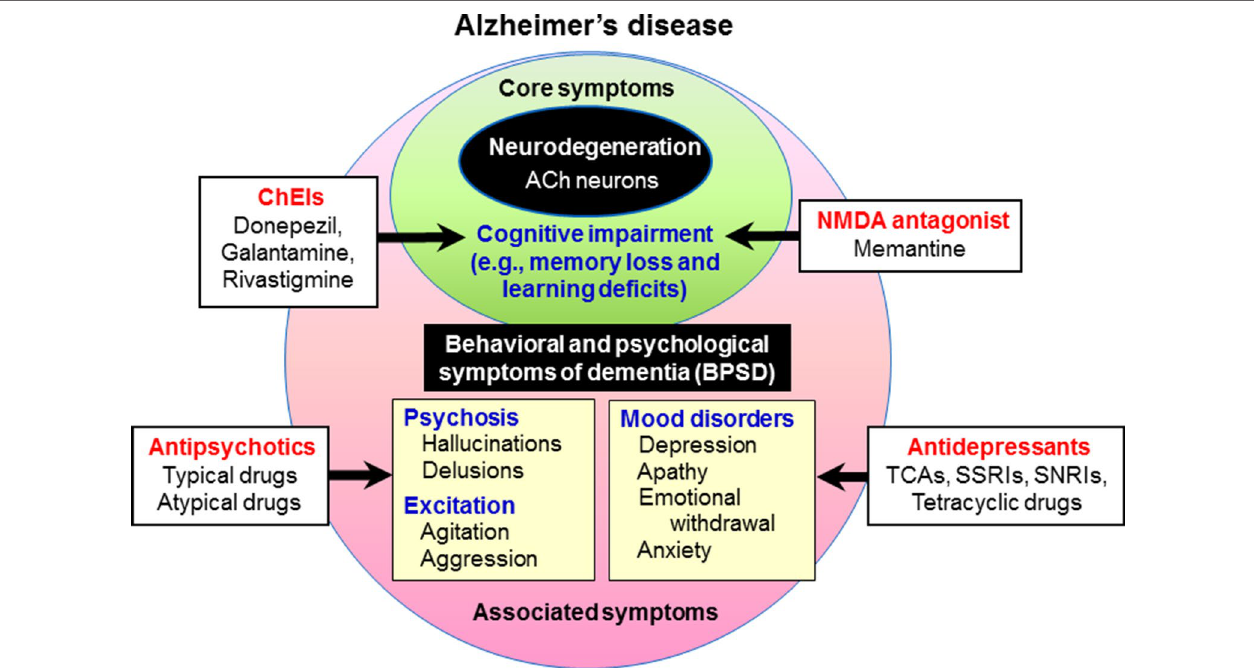
FIGURE 1 | Behavioral and psychological symptoms of dementia (BPSD) in Alzheimer’s disease. Patients with dementia show not only core symptoms of dementia (e.g., memory loss and learning deficits), but also various associated symptoms including BPSD (e.g., psychosis, behavioral excitation, and mood disorders). Cognitive impairment in Alzheimer’s disease is usually treated with cognitive enhancers such as the cholinesterase inhibitors (ChEIs, e.g., donepezil, galantamine, and rivastigmine) and the NMDA antagonist (e.g., memantine). In the treatment of BPSD, antipsychotic drugs are used for psychosis and behavioral disturbances, and antidepressants for depressive